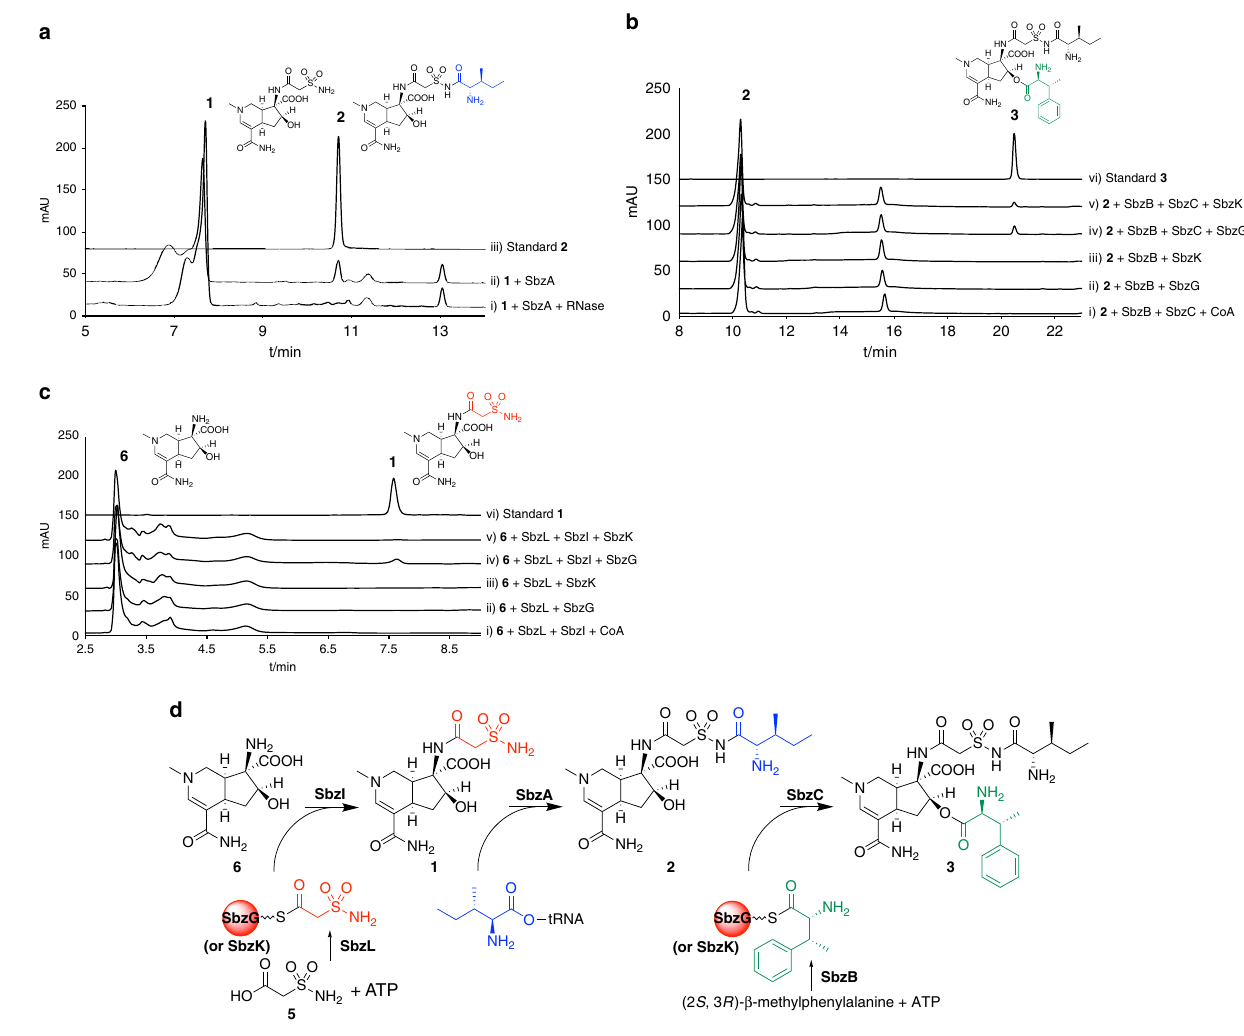
Fig. 3 HPLC analysis (monitored at 300 nm) of the in vitro aminoacyl transfer enzyme reactions. a The assay of SbzA with altemicidin ( 1 ) and Ile-tRNA as substrates; (i) SbzA + RNase, (ii) SbzA, and (iii) the authentic standard of SB-203207 ( 2 ). b The assay of SbzBCG (or BCK) with 2 and β - methylphenylalanine as substrates; (i) SbzB + SbzC + CoA, (ii) SbzB + SbzG, (iii) SbzB + SbzK, (iv) SbzB + SbzC + SbzG, (v) SbzB + SbzC + SbzK, and (vi) the authentic standard of SB-203208 ( 3 ). c The assay of SbzILG (or ILK) with 6 ; (i) SbzL + SbzI + CoA, (ii) SbzL + SbzG, (iii) SbzL + SbzK, (iv) SbzL + SbzI + SbzG, (v) SbzL + SbzI + SbzK, and (vi) the authentic standard of 1 . d Proposed mechanisms of the aminoacyl transfer enzyme reactions